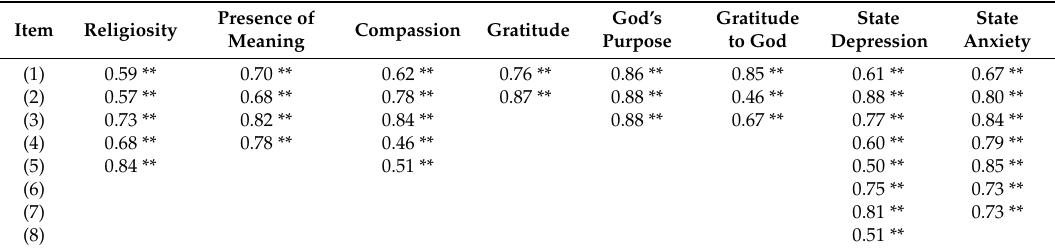
Table A2. Measurement Models: Full